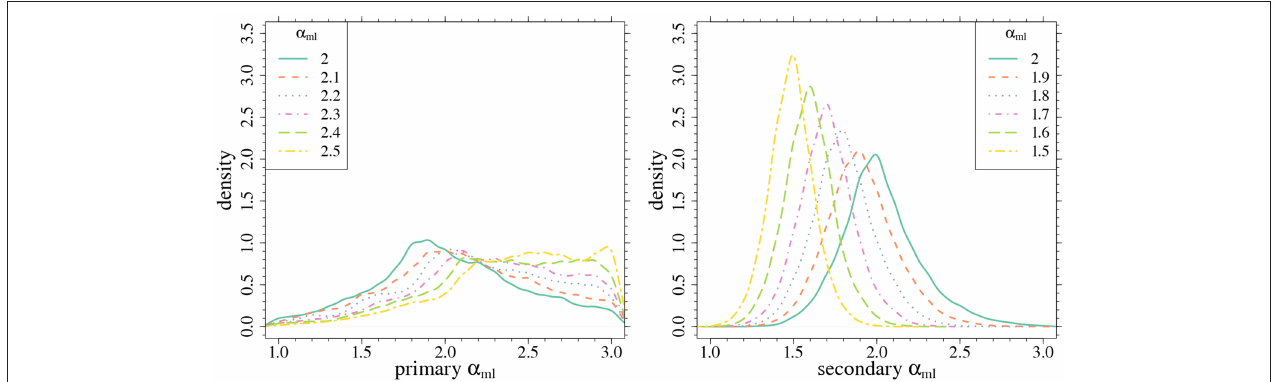
FIGURE 3 | As in Figure 2 , but assuming common age, and common initial Z and Y in the fit.